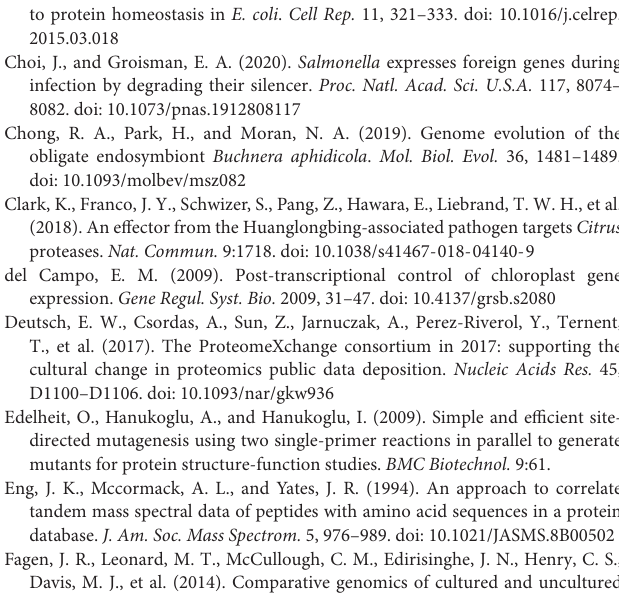
Supplementary Figure 2 | Control of LotP oligomers. Representative chromatogram obtained of His.LotP and LotP.His analyzed by size-exclusion chromatography using a Superose 6 column. The purified proteins were separate according to its native molecular size. Elutions were monitored continuously at 280 nm and the graphic shows the signal at the different elution volumes. Supplementary Figure 3 | Mutation R104A causes structural changes to LotP. SDS-PAGE of samples of purified His.LotP, His.LotP R104A , His.EK.LotP, (cid:49) NLotP.His, and His.EK.LotP R104A proteins analyzed by a limited proteolysis assay. Purified proteins were incubated with proteinase K and aliquots were taken at sequential time points (0, 5, 15, 45, 90, and 240 min) and the degradation was halted with the addition of PMSF. The assay was done in duplicate while a representative gel is shown in the figure. 3.5 µ g of protein were used per time point. Supplementary Figure 4 | LotP and N-terminal domain of Lon proteases Alignment. Alignment of ‘ Ca . L. asiaticus’ LotP sequence (#1) with N-terminal domains of Lon proteases (#2–4). Bacterial species per line is as follows: (1) ‘ Ca . L. asiaticus’ LotP, (2) ‘ Ca . L. asiaticus’ Lon, (3) Escherichia coli Lon, and (4) Bacillus subtilis Lon. Supplementary Figure 5 | Control of protein expression in growth curves by Western blot. (A,B) Western blot using anti-LotP antibodies with samples taken from cultures of wt and (cid:49) lon E. coli strains overexpressing LotP (A) , LotP R104A (B) , or those transformed with the empty pBAD24 vector as a control. (C) Western blot with anti-His antibodies and SDS-PAGE stained with Coomassie blue of samples taken from the growth curves. Figures A-C correspond to samples from growth curves in exponential growth phase from Figures 7A–C , respectively. The assay was done in triplicate while a representative western blot is shown in the figure. Supplementary Figure 6 | Concentration and conformation effects of LotP on plant stress. (A) Citrus sinensis cv. Valencia plants were exposed varying concentration of His.LotP: 4 µ M (medium gray), 8 µ M (black), and 12 µ M (light gray). (B) Citrus sinensis cv. Valencia plants were exposed His.LotP (circle) and His.EK.LotP.FLAG (triangle) at 8 µ M. Photosystem II activity was estimated using the chlorophyll fluorescence parameter F v /F m . Data are averages ± SEM ( n = 7). Differences were identified using two-way ANOVA and Tukey’s post hoc